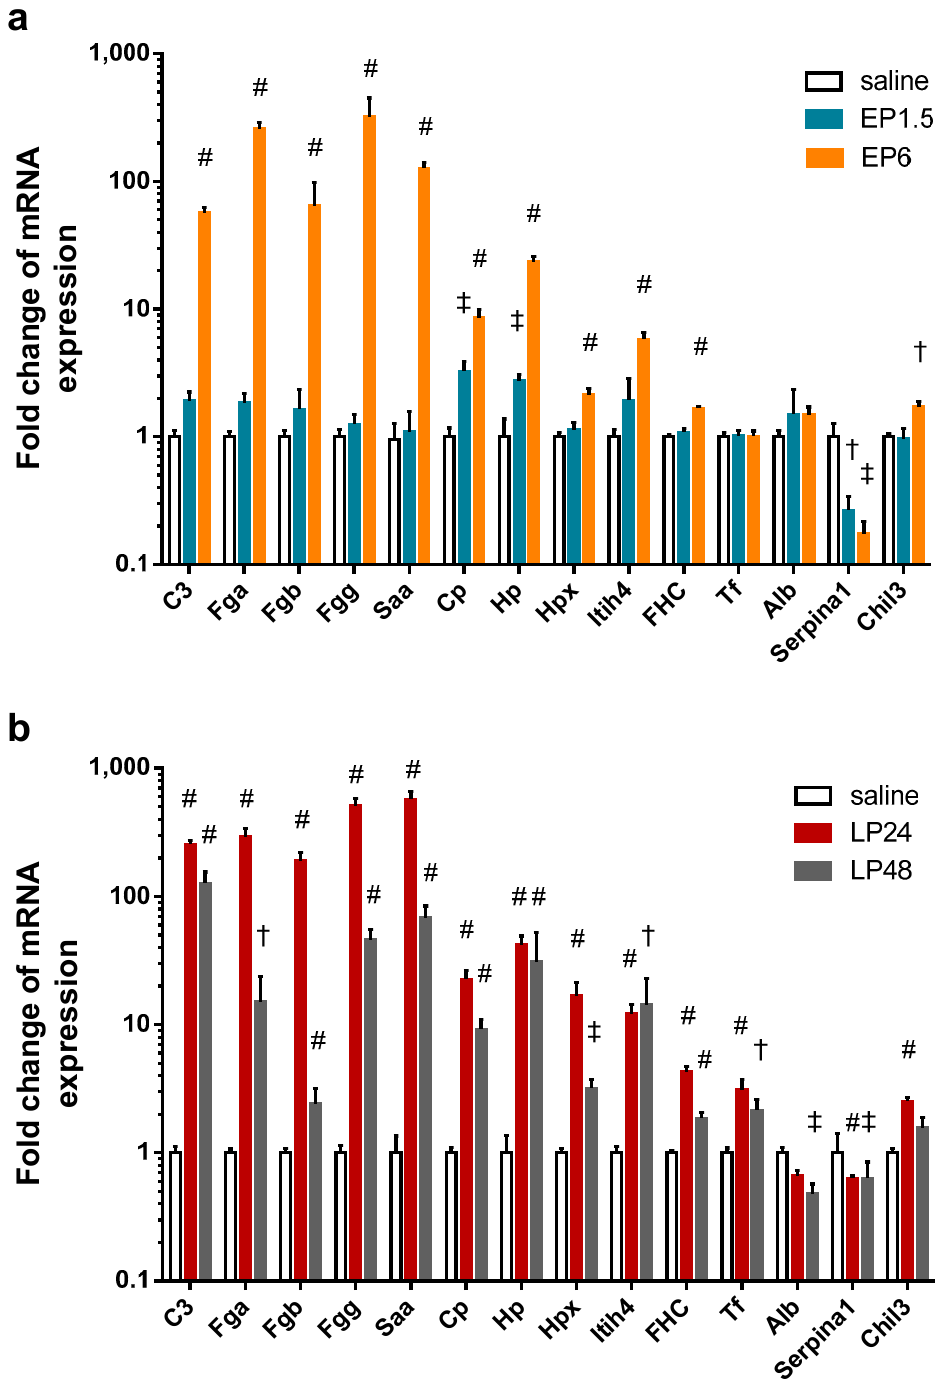
Figure 5. Fold changes of APP mRNA relative to the respective control kidneys in mice after LPS administration. † : p < 0.05, ‡ : p ≤ 0.01, #: p ≤ 0.001. C3: complement C3, Fga: fibrinogen- α , Fgb: fibrinogen- β , Fgg: fibrinogen- γ , Saa: serum amyloid A, Cp: ceruloplasmin, Hp: haptoglobin, Hpx: hemopexin, Itih4: inter alpha-trypsin inhibitor heavy chain 4, FHC: ferritin heavy chain, Tf: transferrin, Alb: serum albumin, Serpina1: alpha-1-antitrypsin, Chil3: chitinase-like protein 3. ( a ) EP1.5, EP6. ( b ) LP24, LP48.